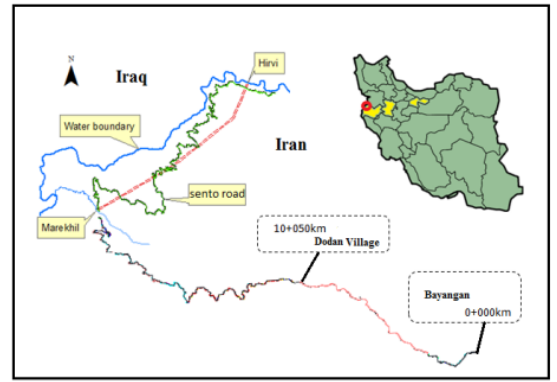
Fig. 1. Location of the study area